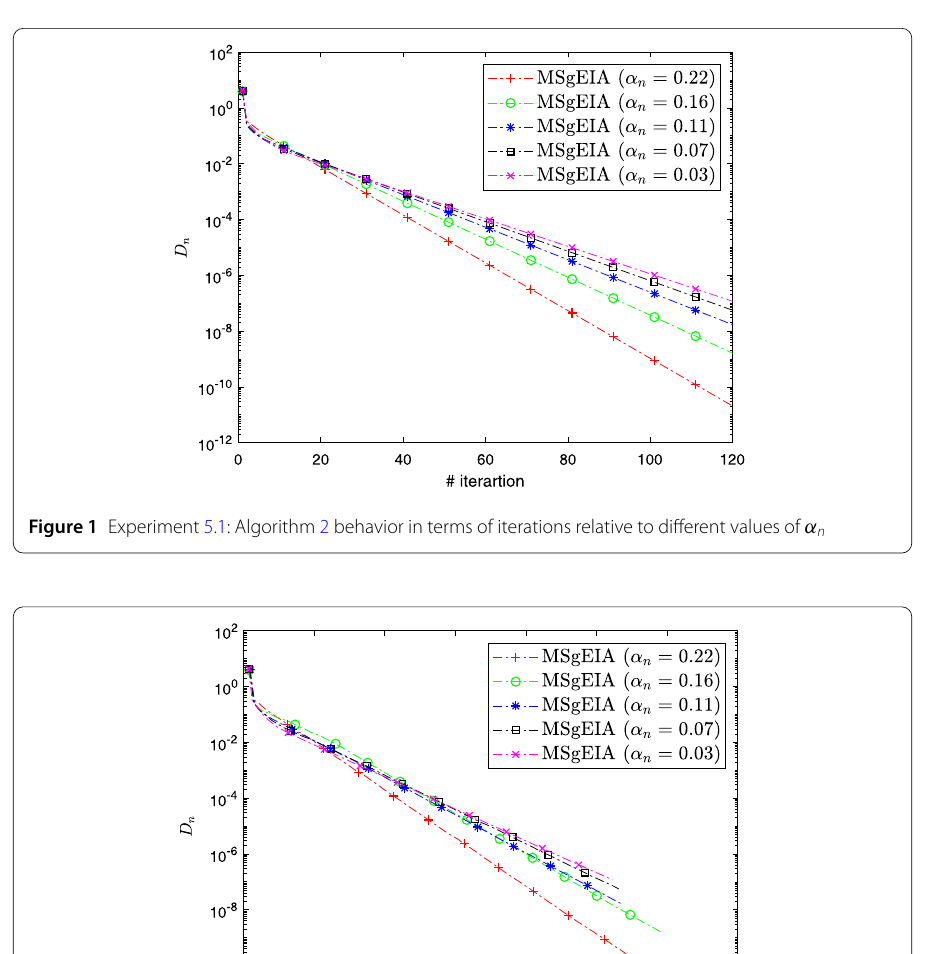
gorithm 1 [Subgradient explicit iterative algorithm (shortly, SgEIA)] and explicit Algo- rithm 1 [Explicit iterative algorithm (shortly, EIA) [47]] in terms of no. of iterations and elapsed time in